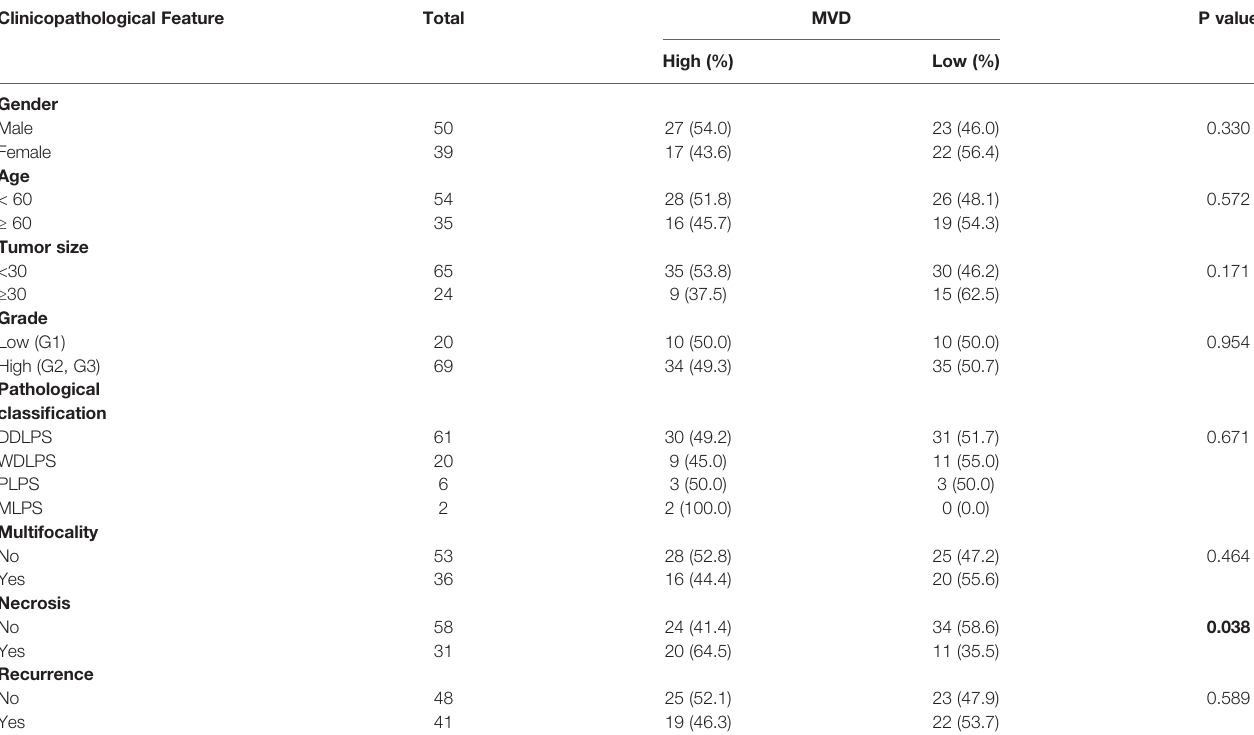
TABLE 1 | Association between microvessel density (MVD) and clinicopathological characteristics of 89 patients with retroperitoneal liposarcoma. Clinicopathological